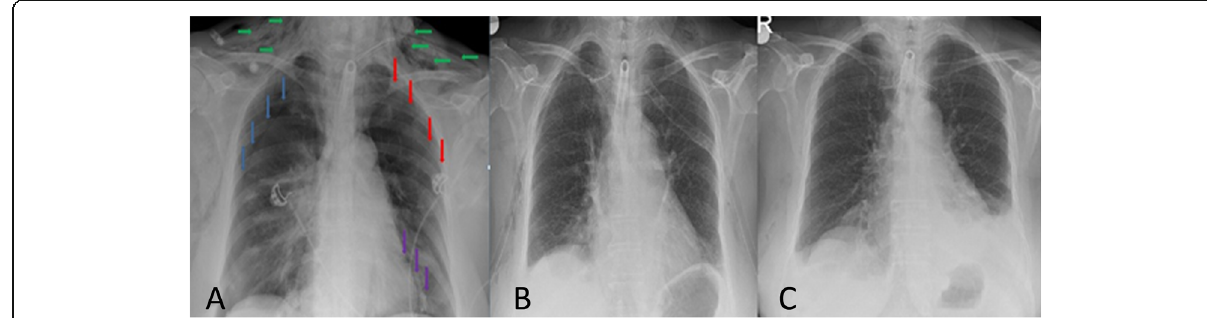
Fig. 2 Bilateral pneumothorax, bilateral thorax tube application, and after removal of throax tubes X-Ray. a Bilateral pneumothorax (red and blue arrows) and subcutaneous emphysema (green arrow), b bilateral thorax tube application, and c chest X-ray after removal of throax